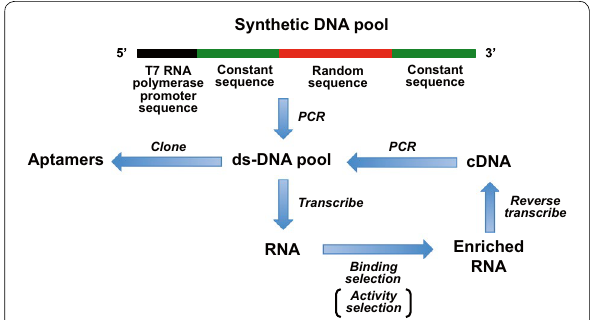
Fig. 15 The general procedure for the in vitro selection of